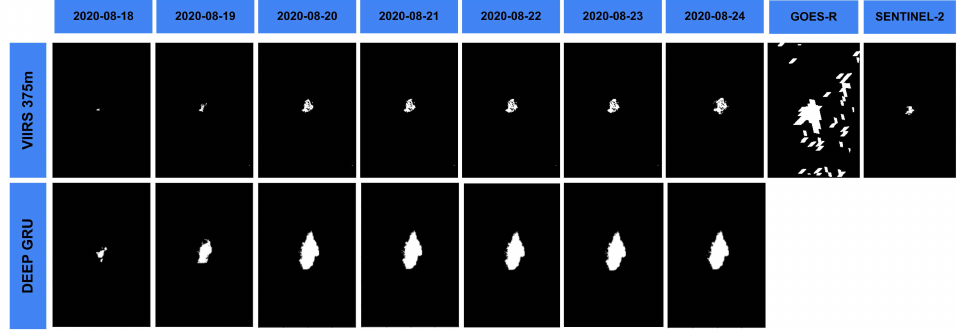
Figure 14. Burned area progression mapping of VIIRS 375 m active fire product and proposed method for 18 to 24 August 2020 until Sentinel-2 image is